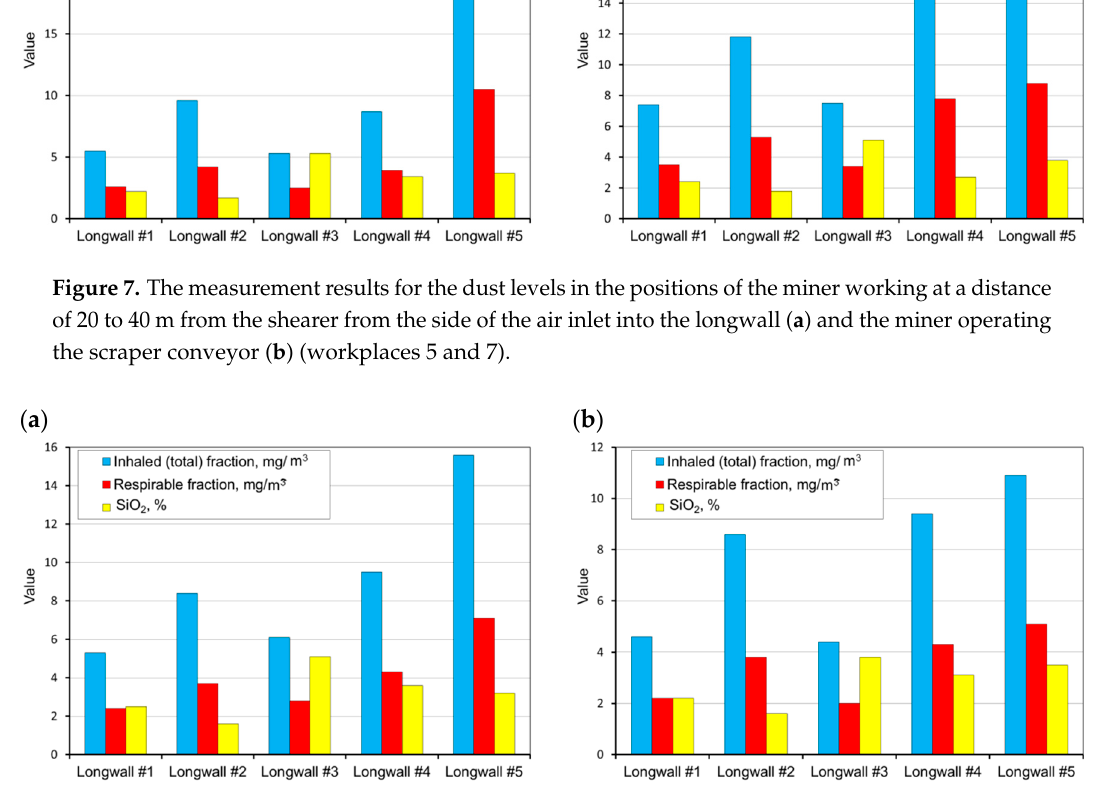
Figure 8. The measurement results for dust levels in the positions of a miner operating the belt conveyor ( a ) and a miner operating the dumper PZ/PT ( b ) (workplaces 8 and 9).